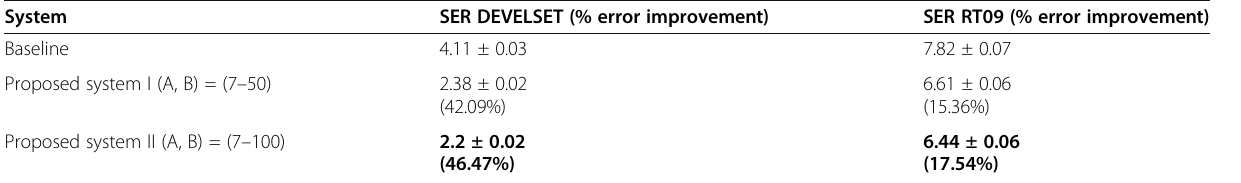
Table 4 SER for the baseline and for the proposed system with two different parameter settings. The percentage improvement over the baseline is presented in brackets